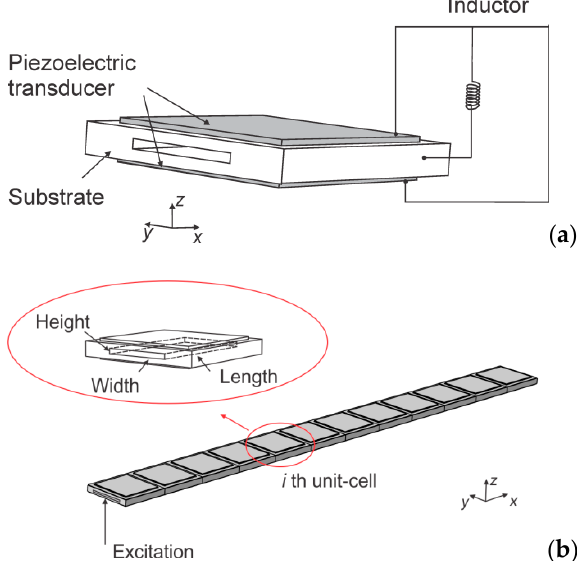
Figure 3. ( a ) Unit-cell with cavity; ( b ) Configuration of the piezoelectric metamaterial and the coordinate system.